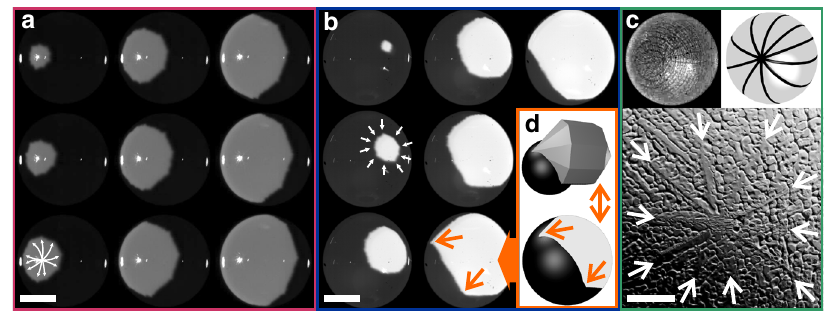
Fig. 1 Decagonal solidi fi cation of deeply undercooled NiZr. HSC snapshots of decagon-shaped solidi fi cation fronts for two samples of NiZr (red and blue a , b , respectively, scale bar 1 mm). An SEM micrograph (green c , scale bar 50 μ m) shows a close-up of the geodesic surface structure of the levitated droplet. A simulation (orange d ) illustrates the shape of the solidi fi cation front as the intersection of the growing crystal, an elongated decagonal bipyramid, with